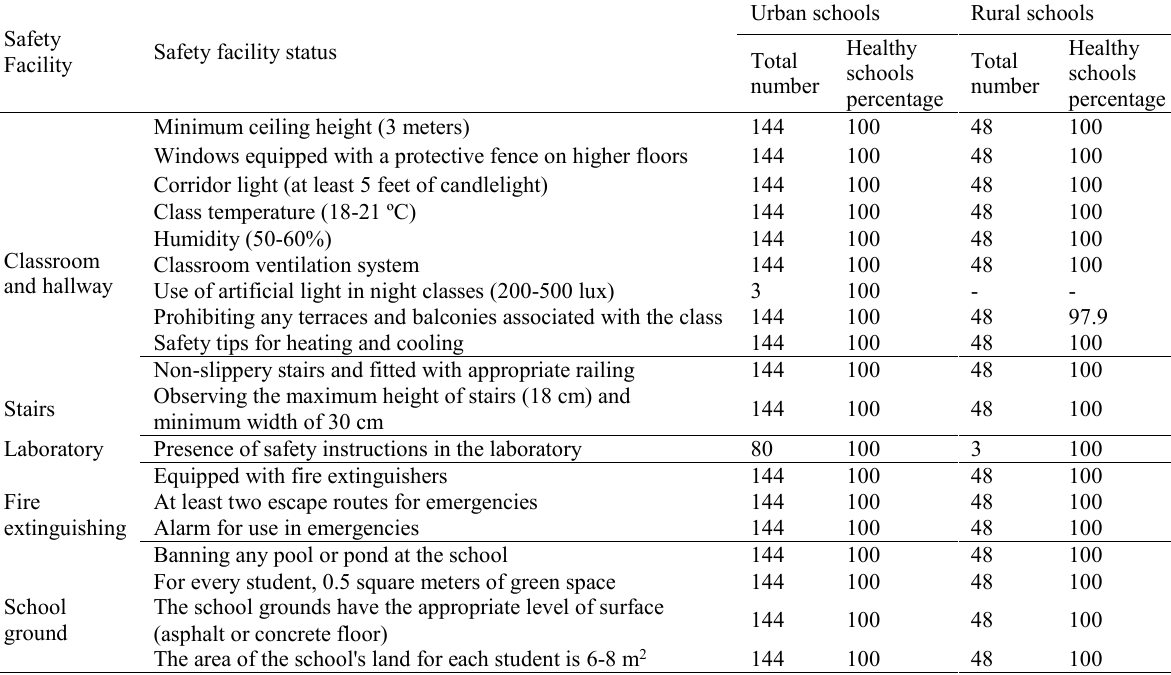
Table 2. Results of health conditions of schools in Abadan from the point of view of safety facilities Safety